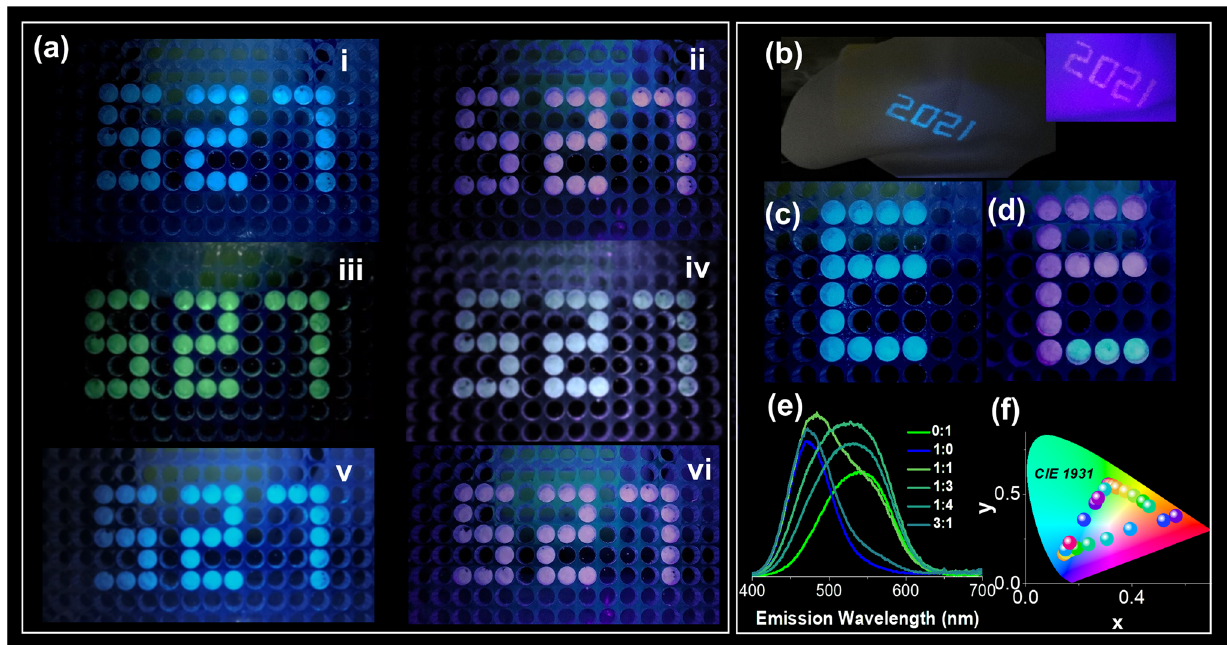
Fig. 5 Anti-counterfeiting and encryption application. a Optical images of Pb-Br: Sb powder encrypted “ 527 ” pattern under different circumstance: exciting at (i) 365 nm and (ii)395 nm UV light; heating at 110 o C and immediately excitation at (iii) 365 nm and (iv) 395 nm UV light; placing at ambient temperature for two days and excitation at (v) 365 nm and (vi) 395 nm UV light. b Optical images of wiper with hand- written “ 2021 ” under 365 nm UV light and 395 nm UV light. Pb-Br: Sb and Pb-Br powder encrypted pattern under ( c ) 365 nm and ( d ) 395 nm UV light. e PL emission spectra of the mixture of two phased Pb-Br: Sb with different weight ratios. f Summarized entire emission color of Pb- Br: Sb under different working